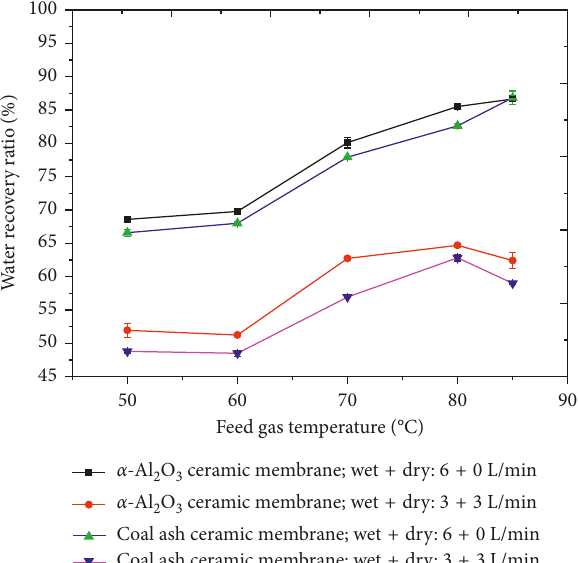
Figure 7: Comparison of water recovery